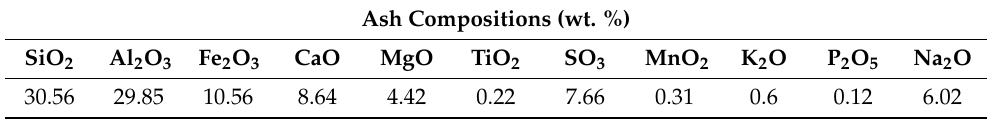
Table 2. Compositional analysis of ZD coal ash. Ash Compositions (wt.